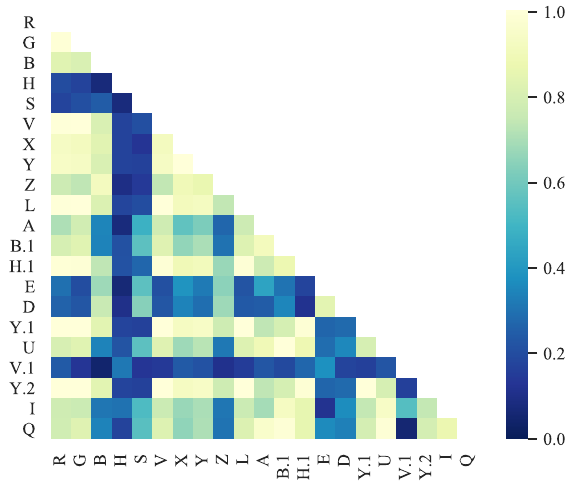
Figure 4. Correlation matrix heat map of color features.